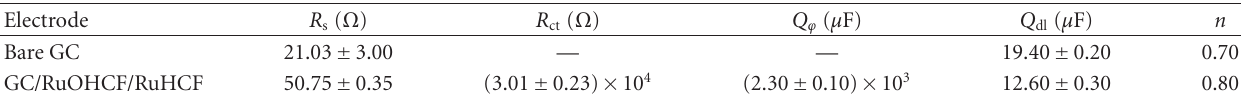
Table 1: Kinetic parameters extracted using EIS data obtained on the bare GC and GC/RuOHCF/RuHCF electrodes in 0.5 MNaNO3 at pH 1.5, in the absence of any external probe, A = 0.0314 cm2, E DC = +0.5.